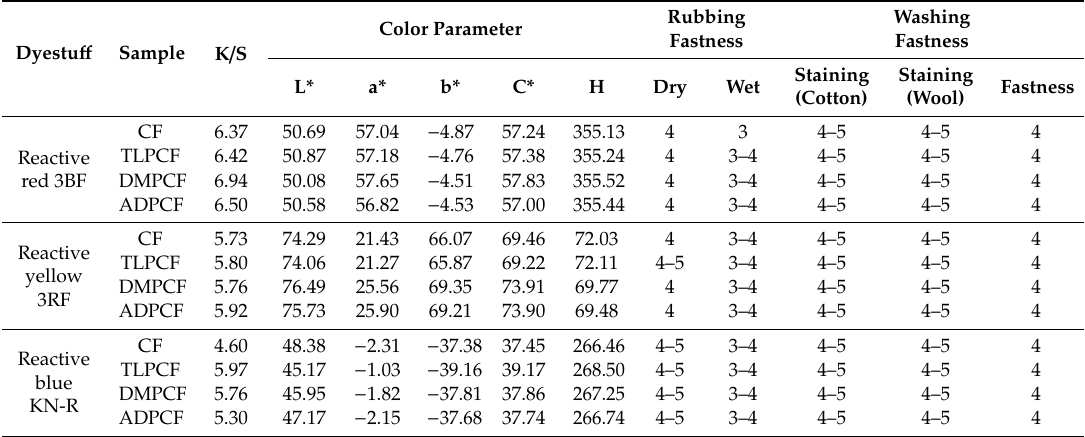
Table 5. K / S value, color parameters, and colorfastness of dyed control and modified cotton